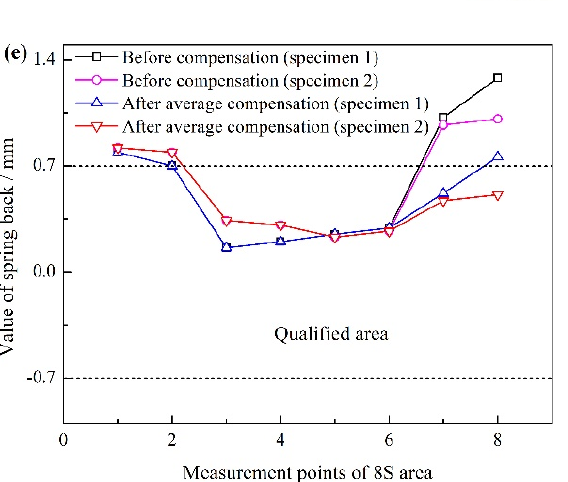
Figure 11. The comparison of spring back values of specimens after compensation: ( a ) 4S area, ( b ) 5S area, ( c ) 6S area, ( d ) 7S area, and ( e ) 8S area.